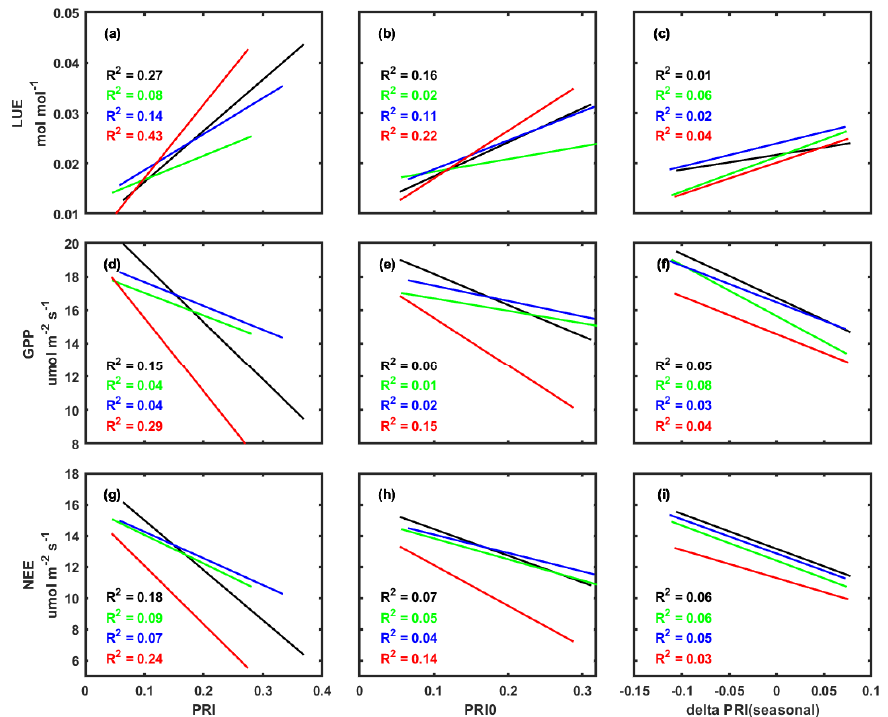
Figure 6. The relationships between daily carbon-related and PRI-related variables: ( a – c ) LUE vs. PRI, PRI0, and ∆ PRI; ( d – f ) GPP vs. PRI, PRI0, and ∆ PRI; ( g – i ) NEE vs. PRI, PRI0, and ∆ PRI. Lines in black, green, blue, and red represent values in 2017, 2018, 2019, and 2020, respectively. All the fitting curves were statistically significant ( p < 0.05). PRI = photochemical reflectance index; LUE = light use efficiency; GPP = gross primary production; NEE = net ecosystem exchange.